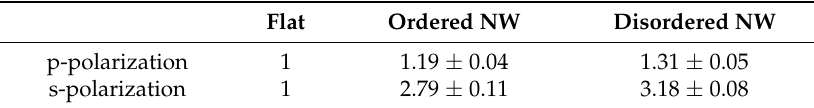
Table 1. The mean values of the integrated Zn K α emission for the investigated targets obtained with p- and s-polarized laser pulse. The values are normalized on the integrated Zn K α flux from the flat sample.